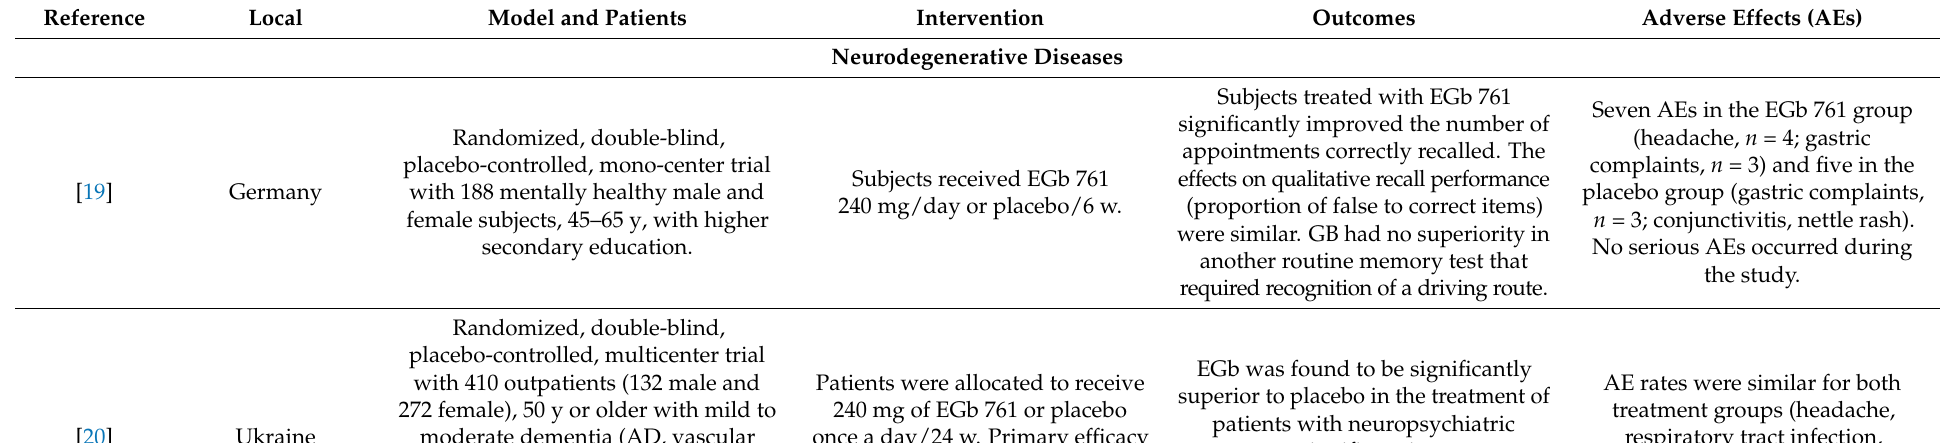
Table 1. The effects of Ginkgo biloba on neurodegenerative diseases, diabetes, and metabolic